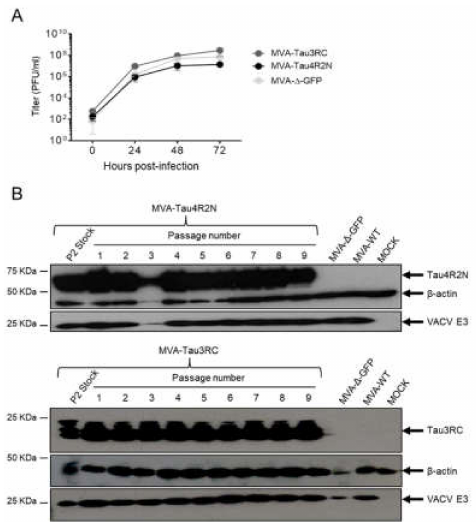
Figure 2. Viral growth kinetics and stability of MVA-Tau4R2N and MVA-Tau3RC. ( A ) Viral growth kinetics of MVA-Tau4R2N and MVA-Tau3RC. Monolayers of DF-1 cells were infected at 0.01 PFU /